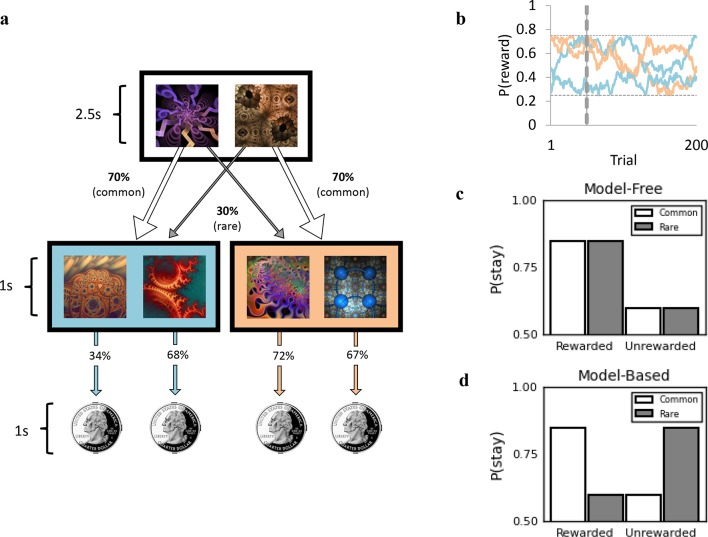
Two-step reinforcement learning task used to assess goal-directed (model-based) learning.(a) Subjects chose between two fractals, which probabilistically determined whether they would transition to the orange or blue second stage state. For example, the fractal on the left had a 70% chance of leading to the blue second stage state (‘common’ transition) and a 30% chance of leading to the orange state (‘rare’ transition). These transition probabilities were fixed and could be learned over time. In the second stage state, subjects chose between two fractals, each of which was associated with a distinct probability of being rewarded with a 25 cents coin. The probability of receiving a reward associated with each second stage fractal could also be learned, but (unlike the transition structure) these drifted slowly over time (0.25 < P <0.75, panel b). This meant that in order to earn the most rewards possible, subjects had to track which second stage fractals were currently best as they changed over time. Reward probabilities depicted (34%, 68%, 72%, 67%) refer to example trial 50, denoted by the vertical dashed line in (b). (b) Drifting reward probabilities determined by Gaussian Random Walks for 200 trials with grey horizontal lines indicating boundaries at 0.25 and 0.75. (c) Schematic representing the performance of a purely ‘model-free’ learner, who only exhibits sensitivity to whether or not the previous trial was rewarded vs. unrewarded, and does not modify their behavior in light of the transition that preceded reward. (d) Schematic representing the performance of a purely ‘model-based’ learner, who is more likely to repeat an action (i.e. ‘stay’) following a rewarded trial, only if the transition was common. If the transition to that rewarded state was rare, they are more likely to switch on the next trial.